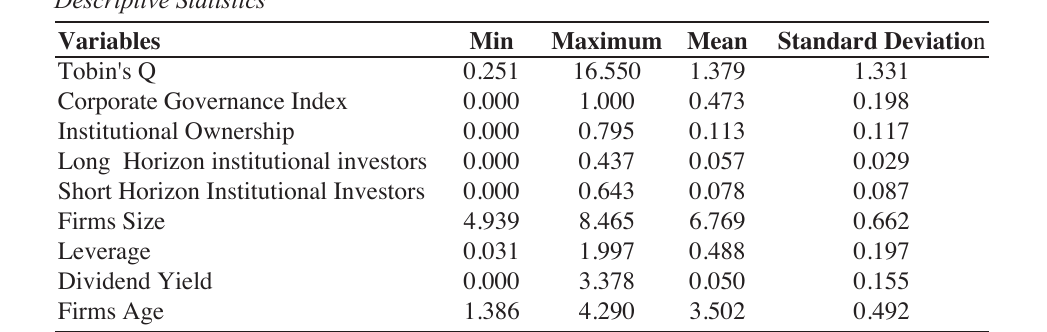
Descriptive Statistics